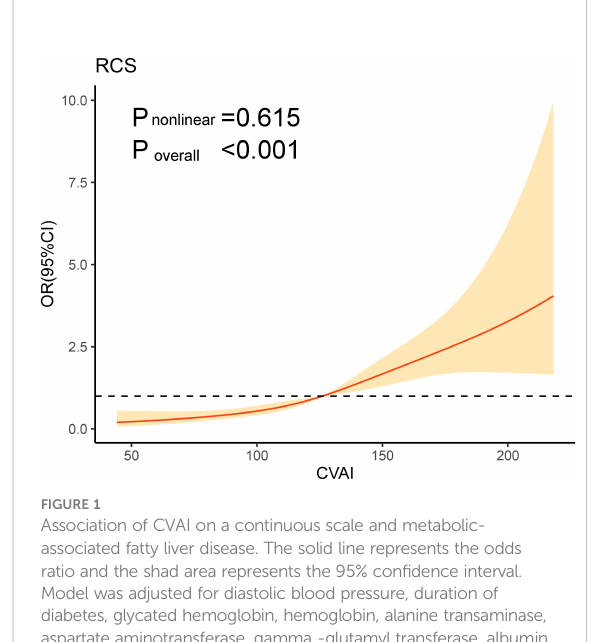
FIGURE 1 Association of CVAI on a continuous scale and metabolic- associated fatty liver disease. The solid line represents the odds ratio and the shad area represents the 95% con fi dence interval. Model was adjusted for diastolic blood pressure, duration of diabetes, glycated hemoglobin, hemoglobin, alanine transaminase, aspartate aminotransferase, gamma -glutamyl transferase, albumin, blood urea nitrogen, total cholesterol, low-density lipoprotein cholesterol, statin use and metformin use. CVAI, Chinese visceral adiposity index; OR, odds ratio; CI, con fi dence interval; RCS, restricted cubic spline.